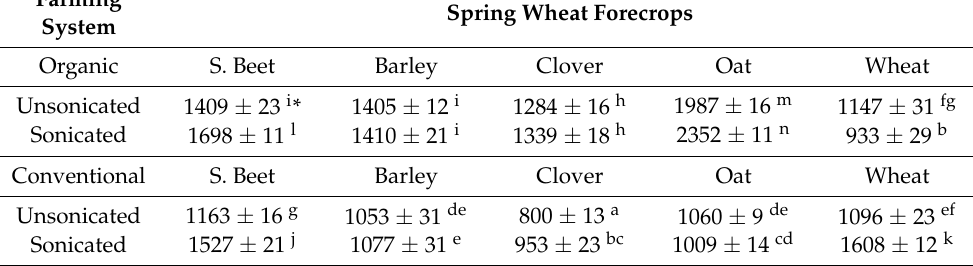
Table 7. Complex modulus (Pa) of gluten samples.